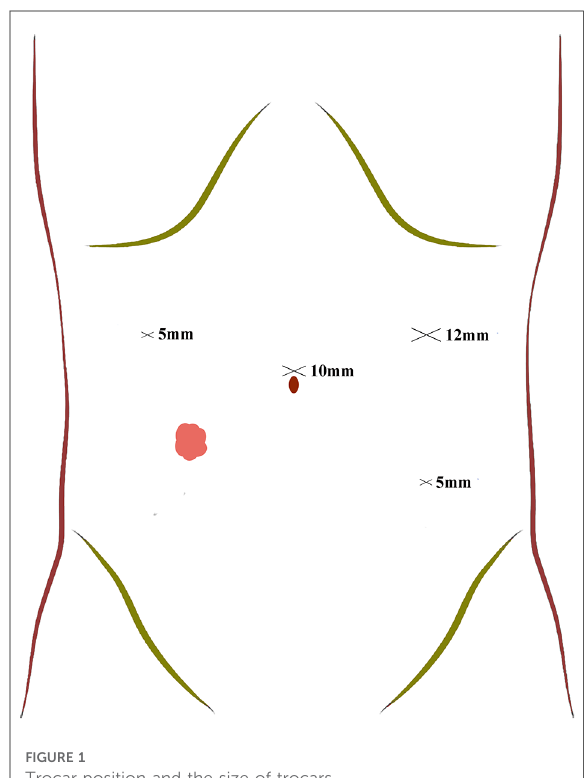
FIGURE 1 Trocar position and the size of